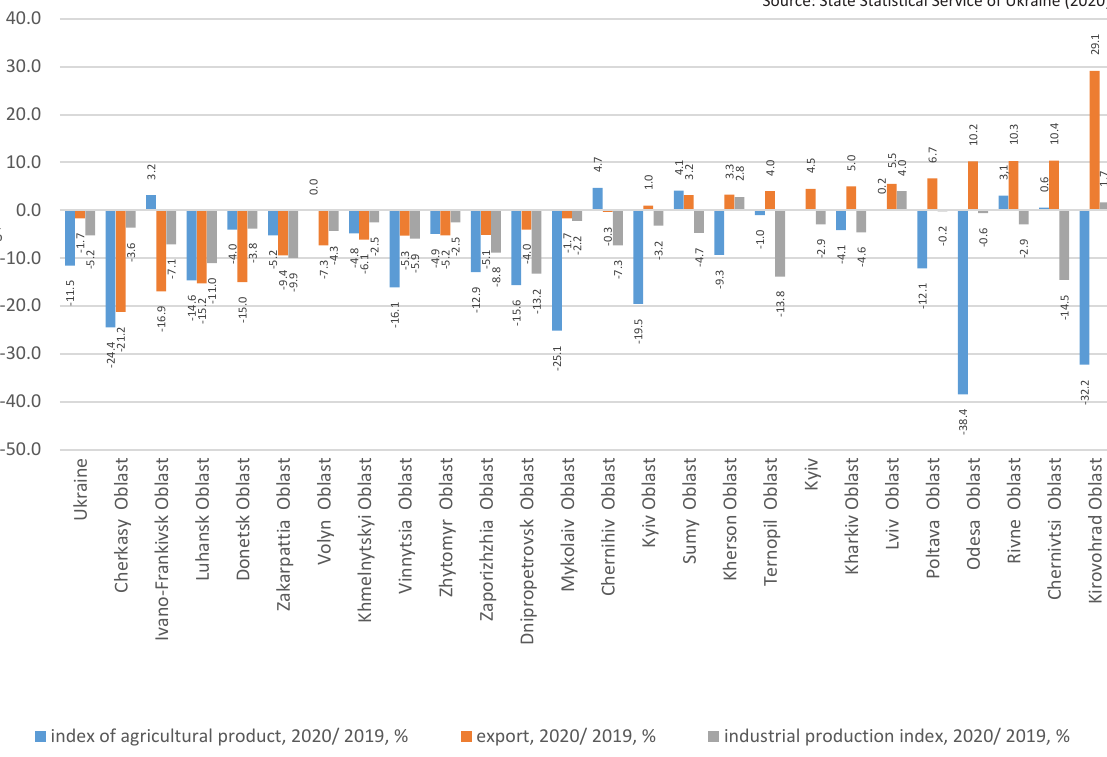
Figure 1. Dynamics of industrial and agricultural production and export of goods in 2020: interregional